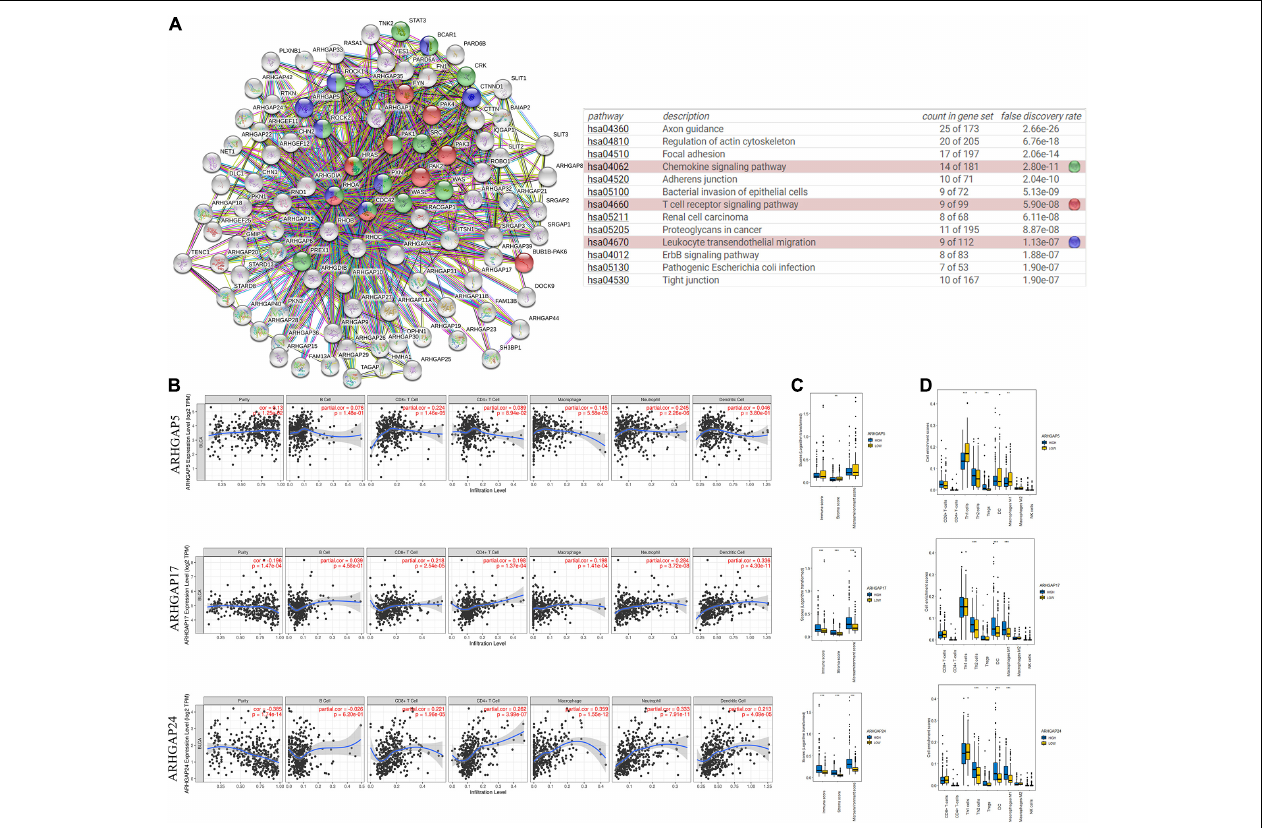
FIGURE 4 | Correlations between prognosis-related ARHGAP family gene-associated immune cell infiltration. (A) Immune-related ARHGAP family gene protein–protein interaction (PPI) network was constructed in STRING. (B) Immune infiltration correlation with ARHGAP5, ARHGAP17, and ARHGAP24 in TCGA-BCa samples were carried out by TIMER. (C) Boxplots were used to visualize ARHGAP family-associated certain cell type enrichment scores and logarithm-transformed immune scores, stroma scores, and microenvironment scores of different groups through xCell-analyzed TCGA samples in BCa. (D) ARHGAP family-associated infiltration of CD8+ T cells, CD4+ T cells, type 1 T-helper (Th1) cells, type 2 T-helper (Th2) cells, natural killer (NK) cells, Treg cells, M1 macrophages, M2 macrophages, and dendritic cell were analyzed through xCell-analyzed TCGA samples in BCa. Grouping was done according to the expression level of prognosis-related ARHGAP family gene (* p < 0.05; ** p < 0.01; *** p < 0.001; ns, not statistically significant, Wilcoxon signed rank